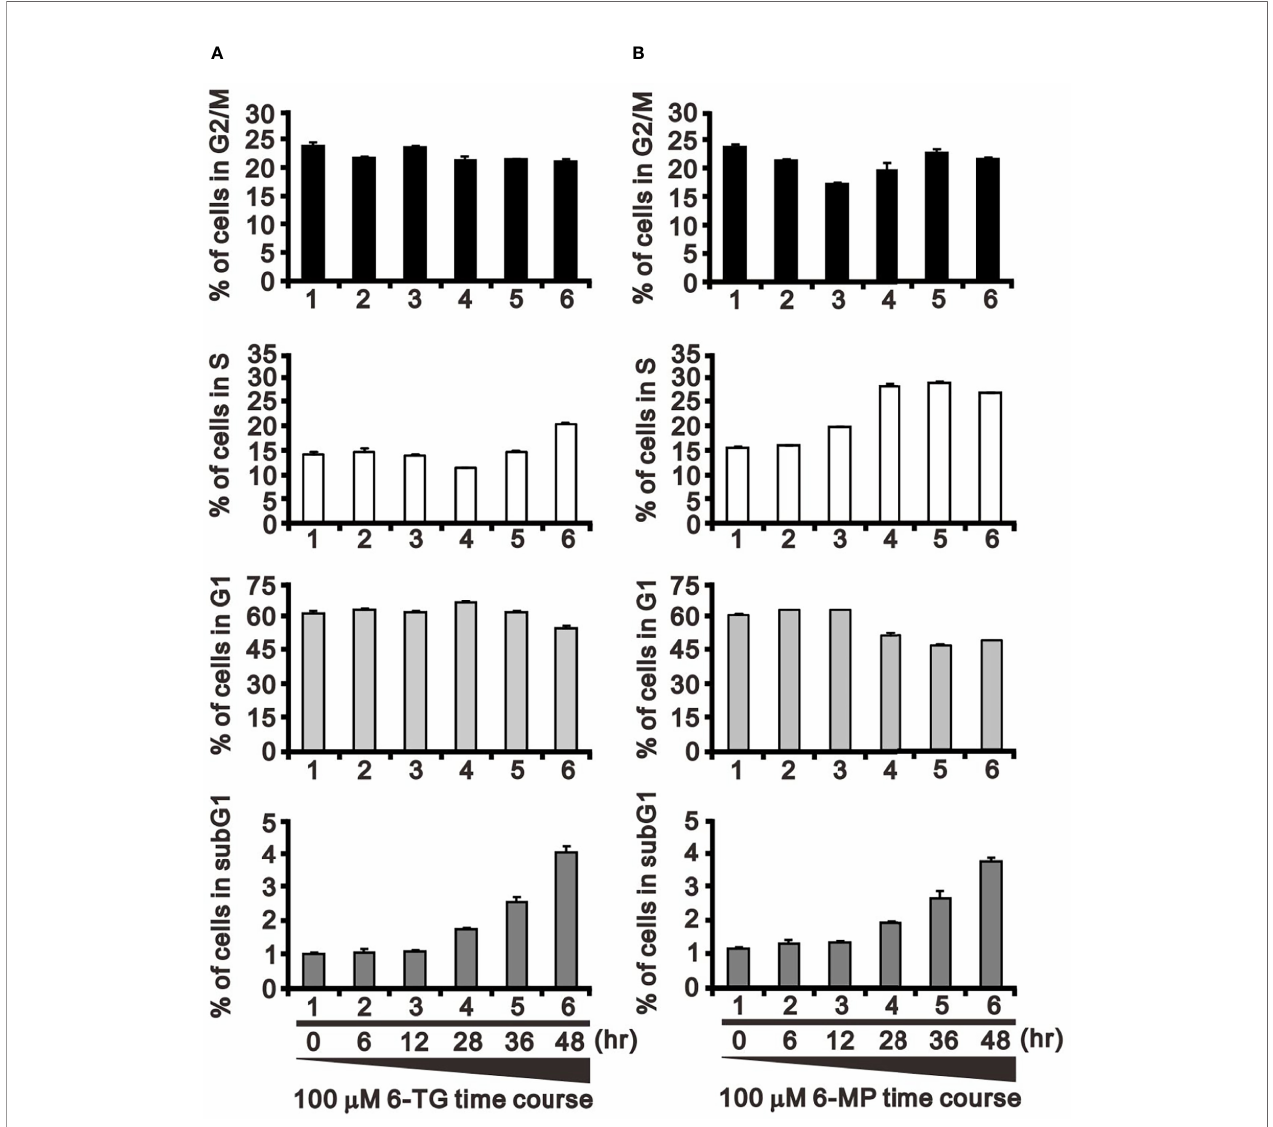
FIGURE 6 | Effects of 6-TG and 6-MP on the cell cycle pro fi le in A253 cells. Cells were treated for the indicated times with 100 m M 6-TG (A) or 6-MP (B) , after which the populations at the indicated cell cycle phases were quanti fi ed using fl ow cytometry. Dead cells were detected based on PI